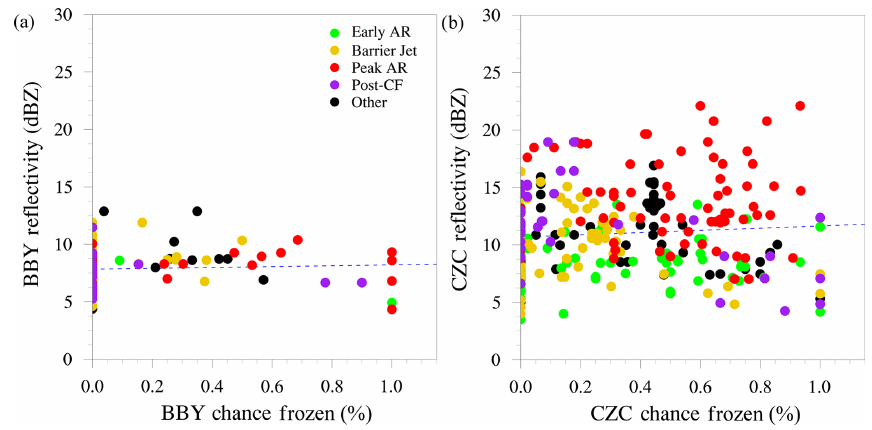
Figure 8. (a) Relationship between P BBY (abscissa) and BBY mean reflectivity (dBZ – ordinate) from all KDAX scans detecting precipi- frz tation at the BBY azimuth. Marker color depicts the kinematic period each scan belonged to, as coded by color in the legend. (b) As in (a) , except for P CZC and CZC mean reflectivity frz